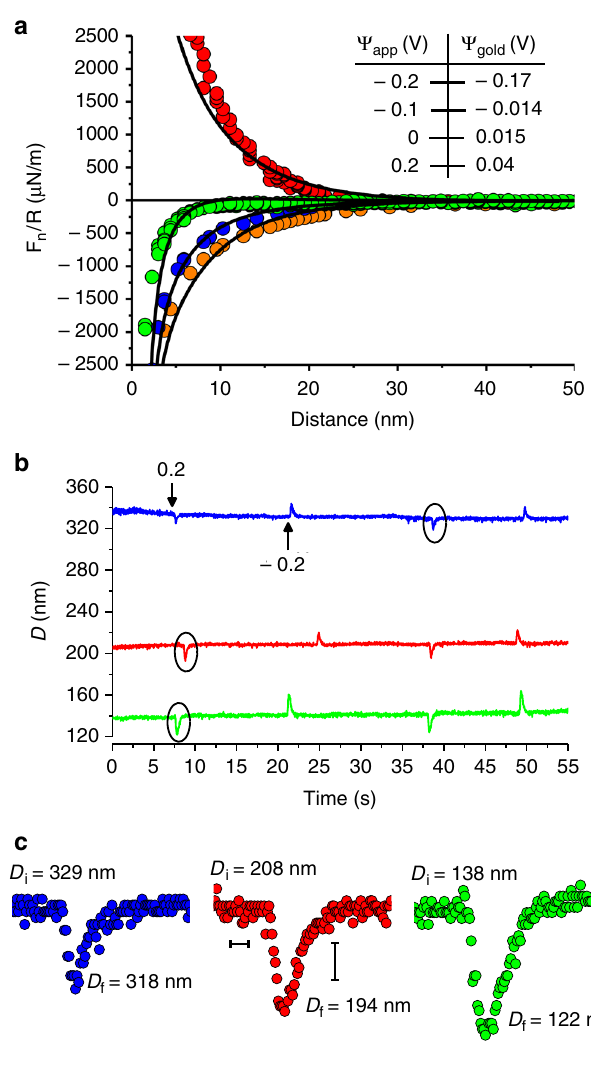
Fig. 2 a Interaction pro fi les F n ( D )/ R between gold and bare mica surfaces across 2 mM NaNO 3 , at a given contact point, under different applied potentials Ψ app . Gold surface potential Ψ gold values in legend are extracted from respective fi ts (black curves) to the PB equation with constant charge (mica) vs. constant potential (gold) boundary conditions, augmented by vdW attraction 44,45 . b An example for dynamic measurements ( D ( t ) plots) taken at different surface separations, in response to positive and negative step potential between – 0.2 V and + 0.2 V. The peaks indicate the transient movement of the lower surface (mica) in response to application of the step potential changes. Measurements both of the interaction pro fi les ( a ) and the response to potential changes were performed between the same surfaces and salt solution (2 mM NaNO 3 ). c A magni fi ed view of transient peaks (circled in the D ( t ) plots in b ) obtained at different gold- mica separations, where D i and D f are the initial and extremal surface separation values, respectively. Scale bars: horizontal – 0.2 s; vertical – 5